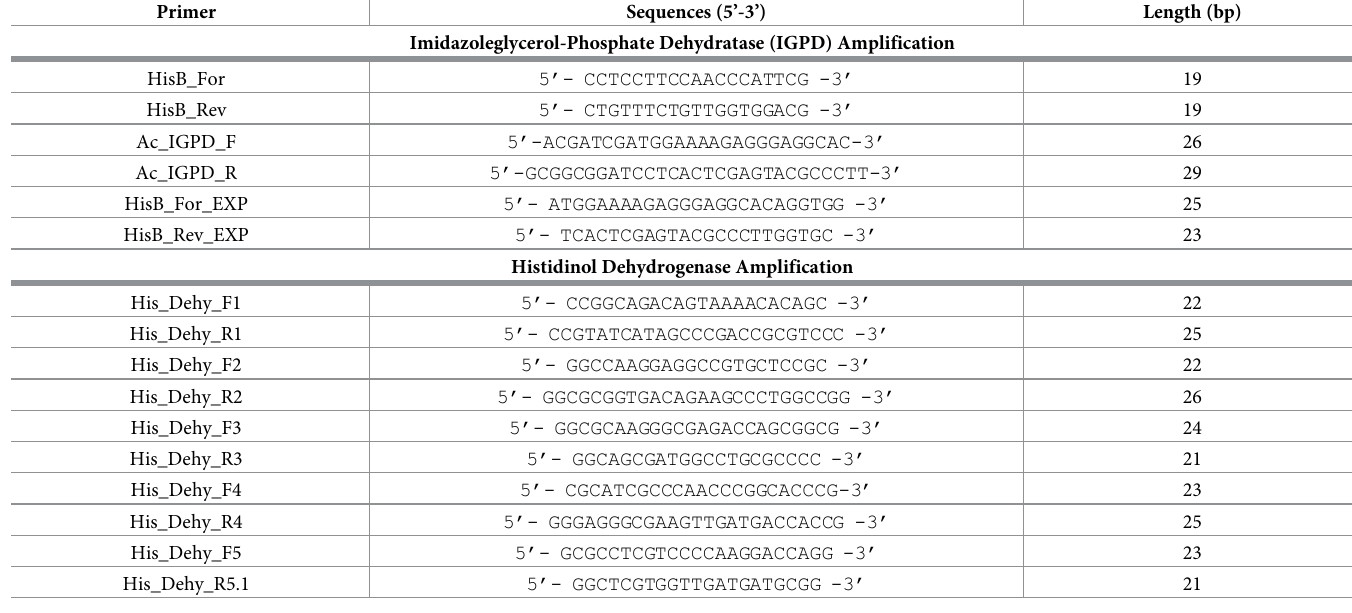
Table 2. Primers used for the amplification of Imidazoleglycerol-Phosphate Dehydratase (IGPD) and histidinol dehydrogenase.